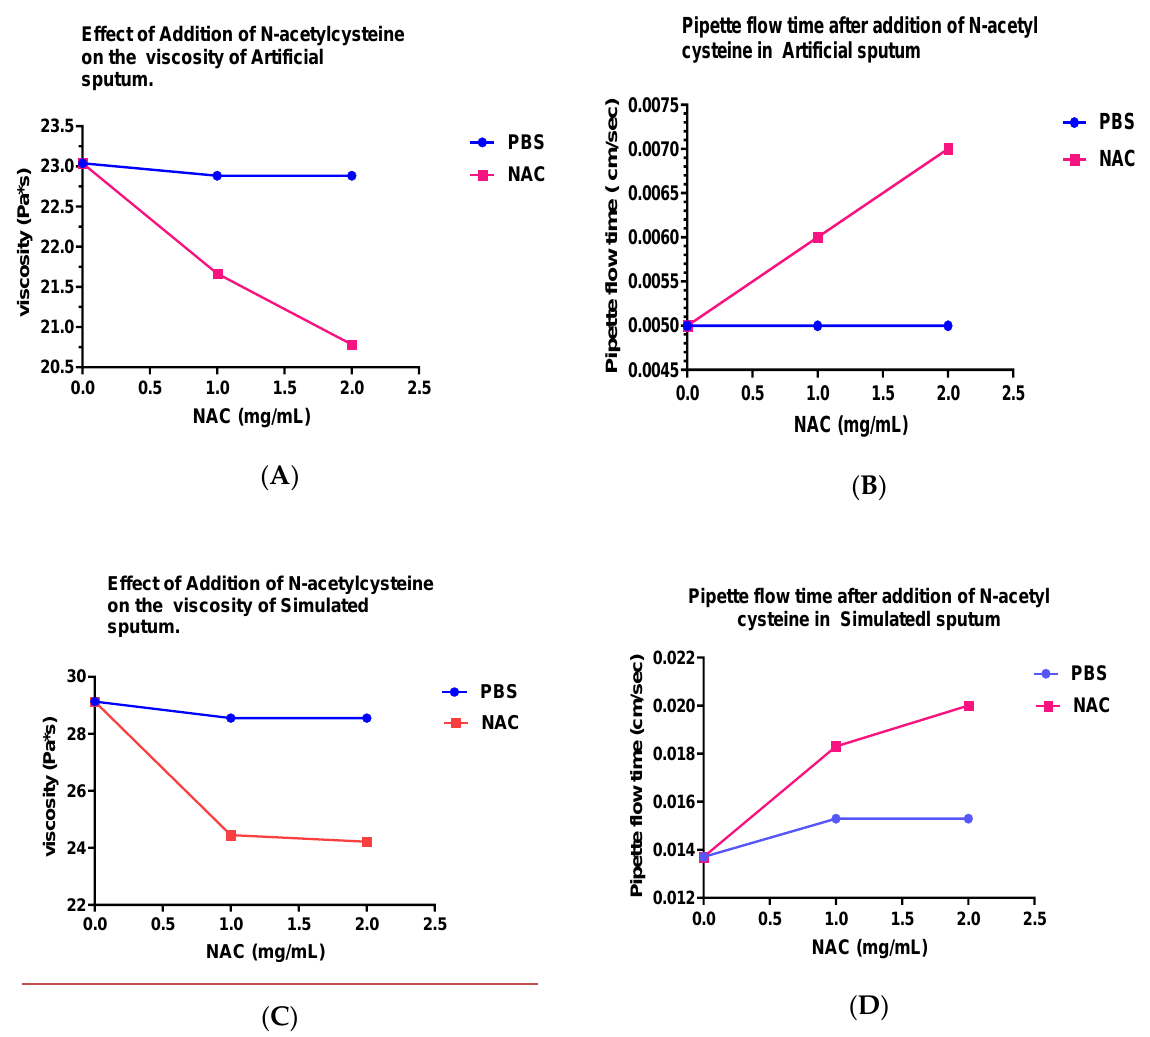
Figure 2. ( A ) In artificial sputa (AS), with the addition of N-Acetylcysteine, there was a noticeable concentration-dependent reduction of viscosity. ( B ) In AS, there was a linear increase in pipette sputum flow with the addition of increasing amounts of NAC. ( C ) There was a considerable drop in viscosity of simulated sputum (SS) with the addition of NAC 10 and 20 mg/mL, as compared to control. ( D ) The increase in pipette sputum flow after the addition of increasing amounts of NAC in SS model.